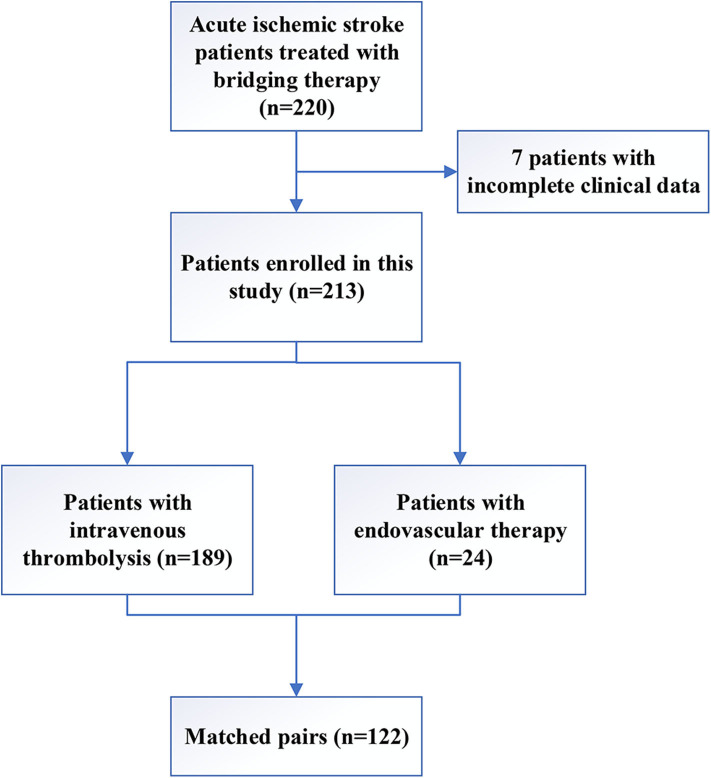
Flowchart showing study participant selection.